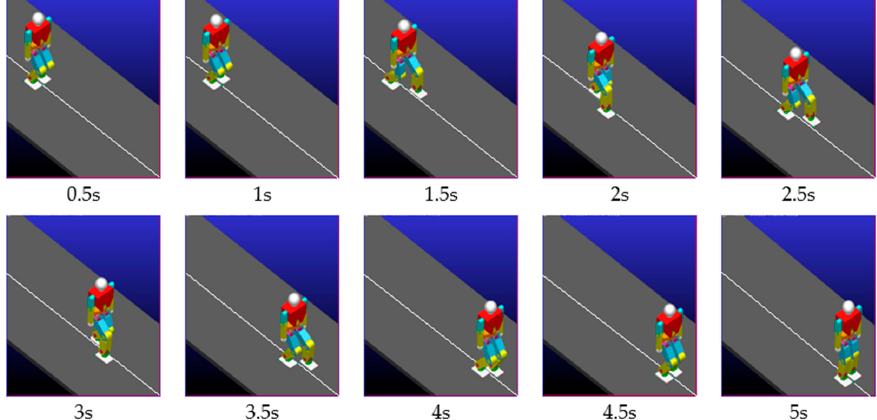
Figure 4. Snapshots of biped walking in Case 1. The robot walks straightly along the center line all the time stably.